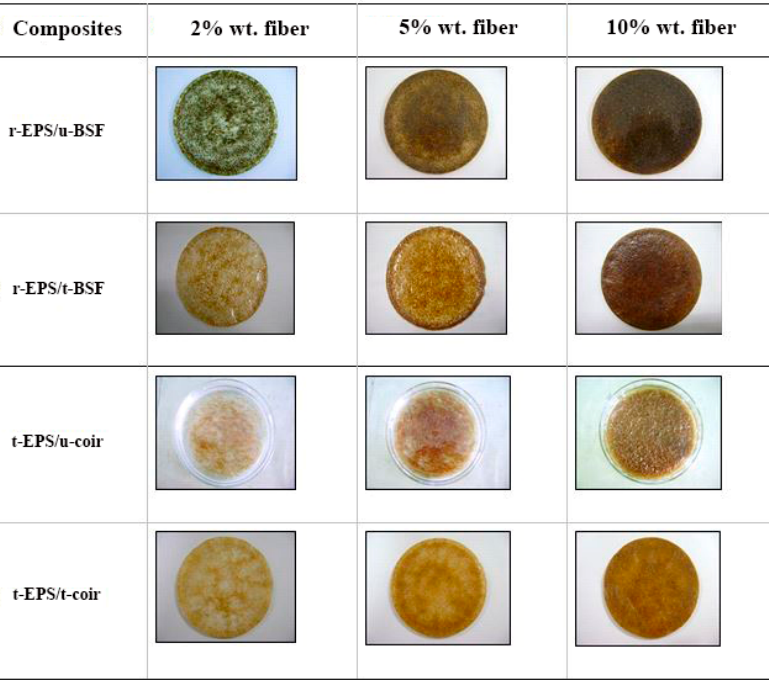
Figure 4. Digital photographs showing the distribution characteristics of fibers in the recycled EPS (r-EPS) foam/natural fiber composite sheets prepared at different fiber loadings. (r-EPS) foam/natural fiber composite sheets prepared at different fiber